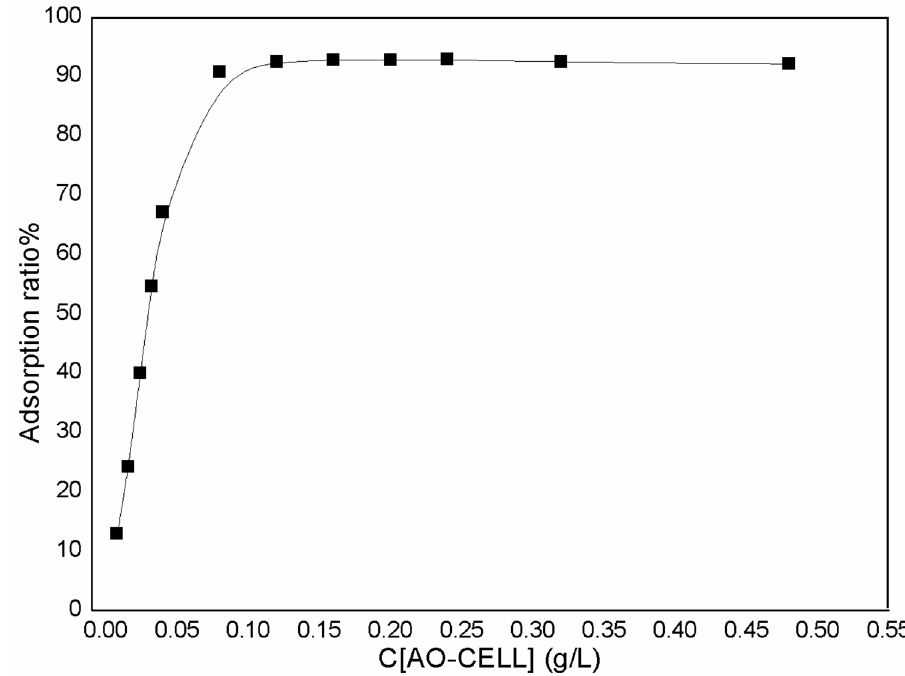
Figure 6. Effect of adsorbent dose on Th(IV) adsorption by CO-CELL. (Experiment conditions: C 0 [Th(IV)] = 19.00 ± 0.10 mg/L; pH = 3.00 ± 0.05; T = 298.15 ± 1.00 K; t = 0.5 h.)